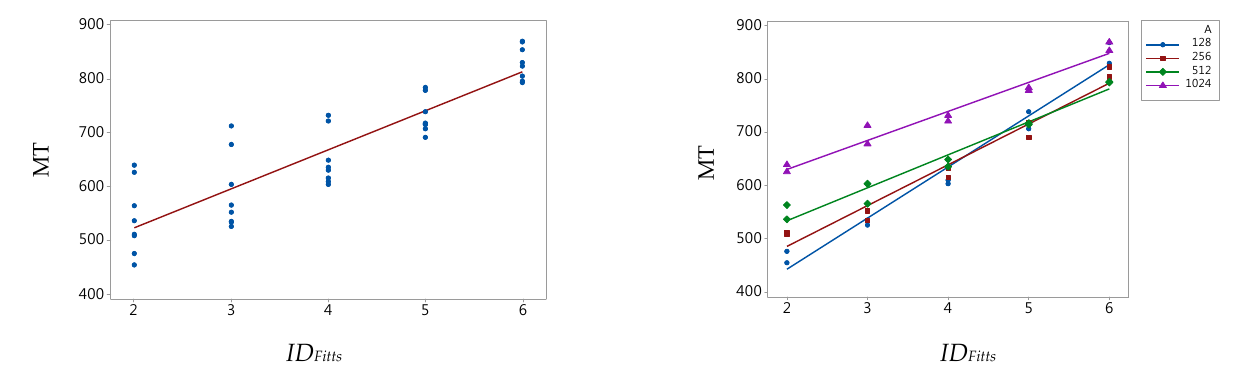
Figure 7. The scatter plot with the regression line. The regression line in the graph on the left presents the results for ID Fitts in the Canon model with all observations. It implies that the variances of varied ID were not equal. For the same amplitude for regression analysis, the graph on the right shows that the slopes of the lines are